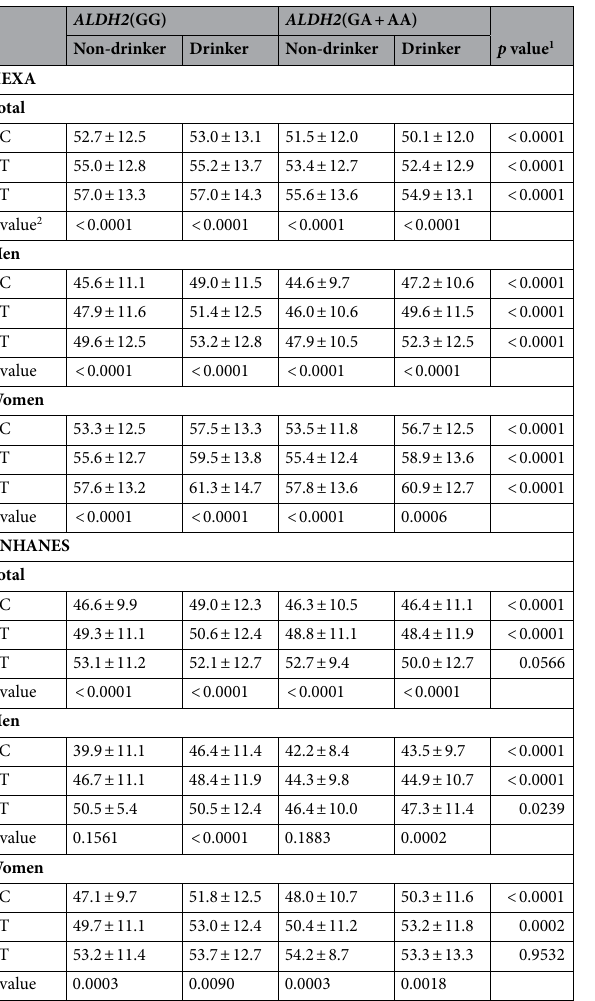
Table 4. Effects of CETP genotype and alcohol consumption on HDL-cholesterol according to ALDH2 genotype. Data are expressed as means ± standard deviations. 1 General linear models by CETP genotypes in each group, and differences between alcohol consumption and ALDH2 genotype. 2 General linear models were used to assess CETP genotype differences in variables between alcohol consumption and HDL-cholesterol by ALDH2